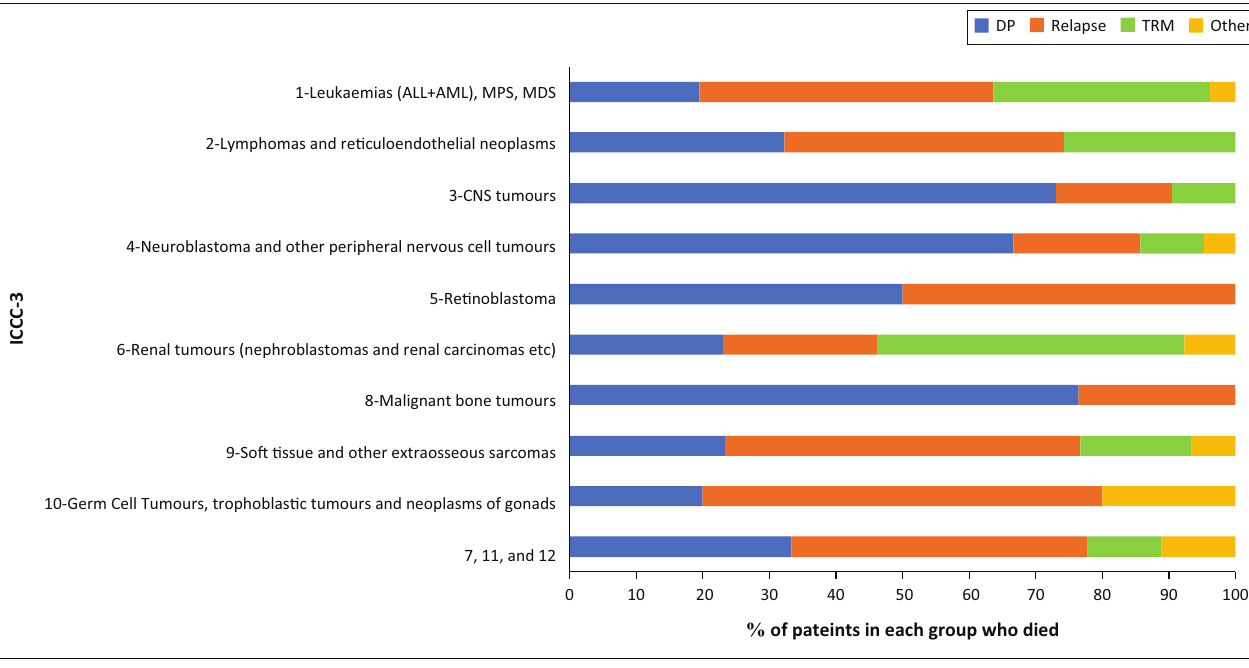
FIGURE 1 : Causes of death per International Classification of Childhood Cancers 3rd edition